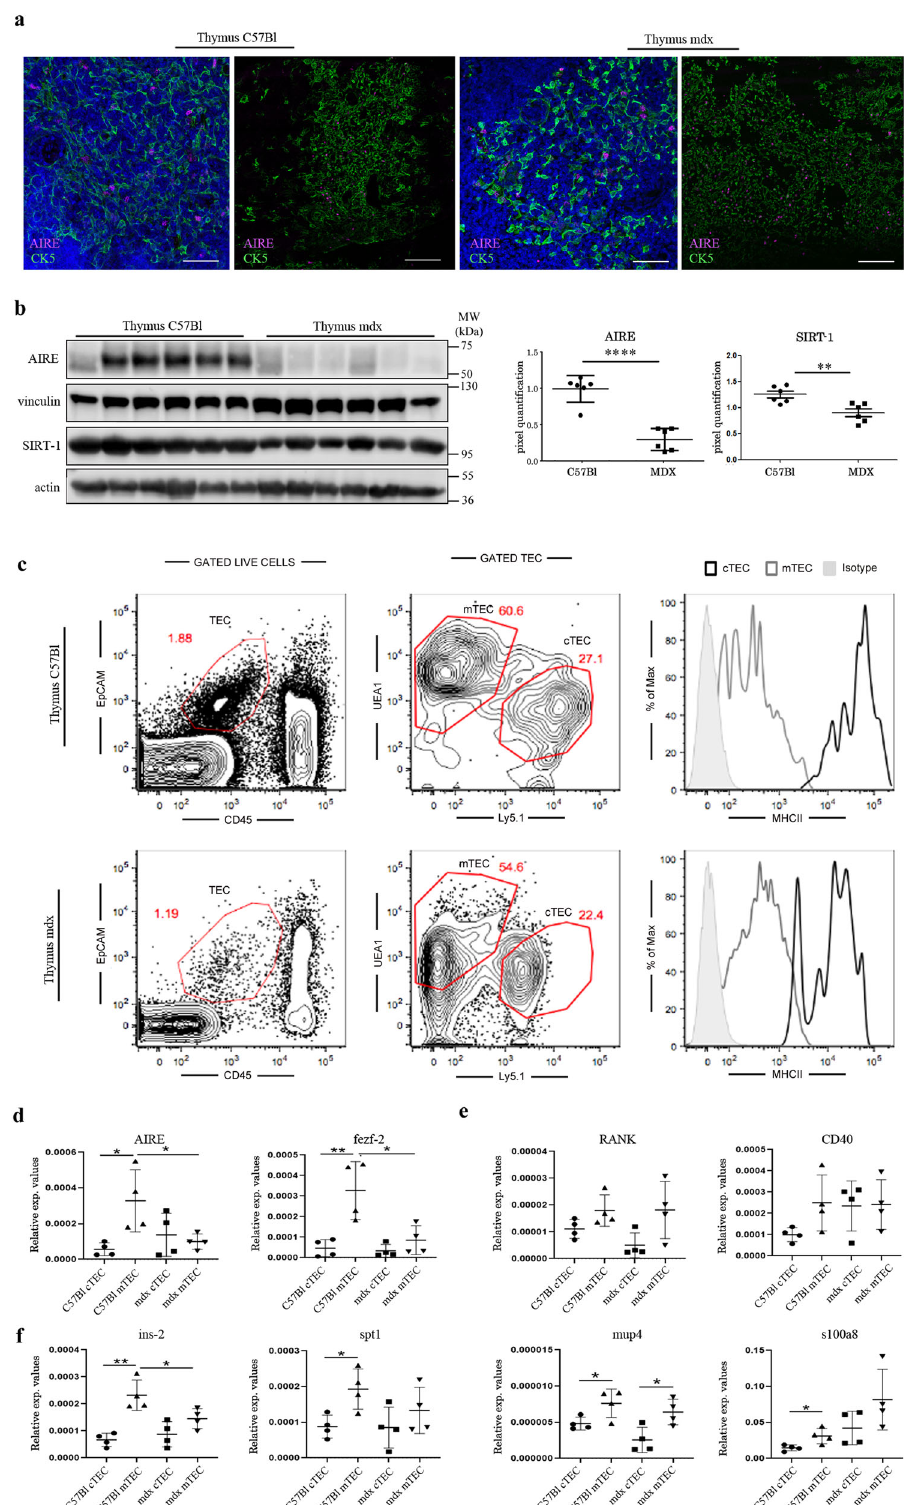
Tnu C57Bl and nu PBS mice (Fig. 6f). Thus, we measured the expression of muscle RING- fi nger protein ( MuRF )-1 as a downstream signalling effect of muscle atrophy and controller